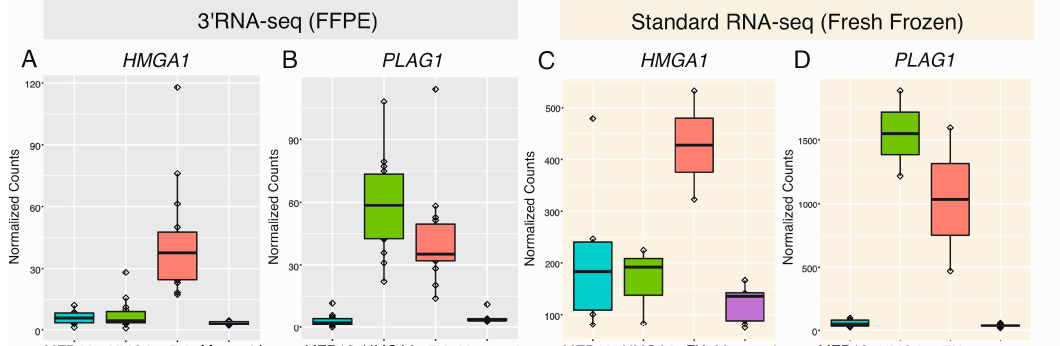
Figure 5. Expression of HMGA1 and PLAG1 in di ff erent leiomyoma subtypes and myometrium samples. ( A , C ) In both the FFPE and fresh frozen datasets, significant upregulation of HMGA1 was only seen in the leiomyomas of the FH subtype, ( B , D ) whereas significant upregulation of PLAG1 was seen in both leiomyomas of the HMGA2 and FH subtypes, but not in leiomyomas of the MED12 subtype nor the myometrium